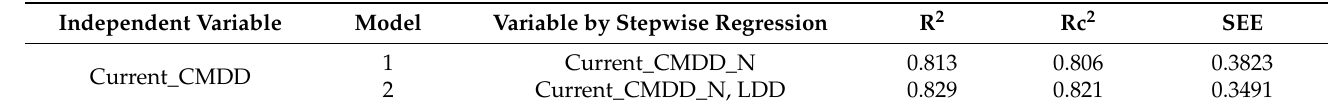
Table 4. Results of CCLM